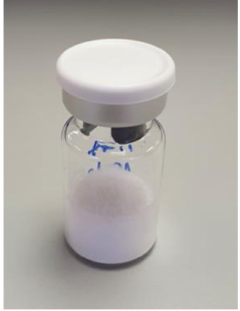
Figure 1. Azelaic acid nanocrystals